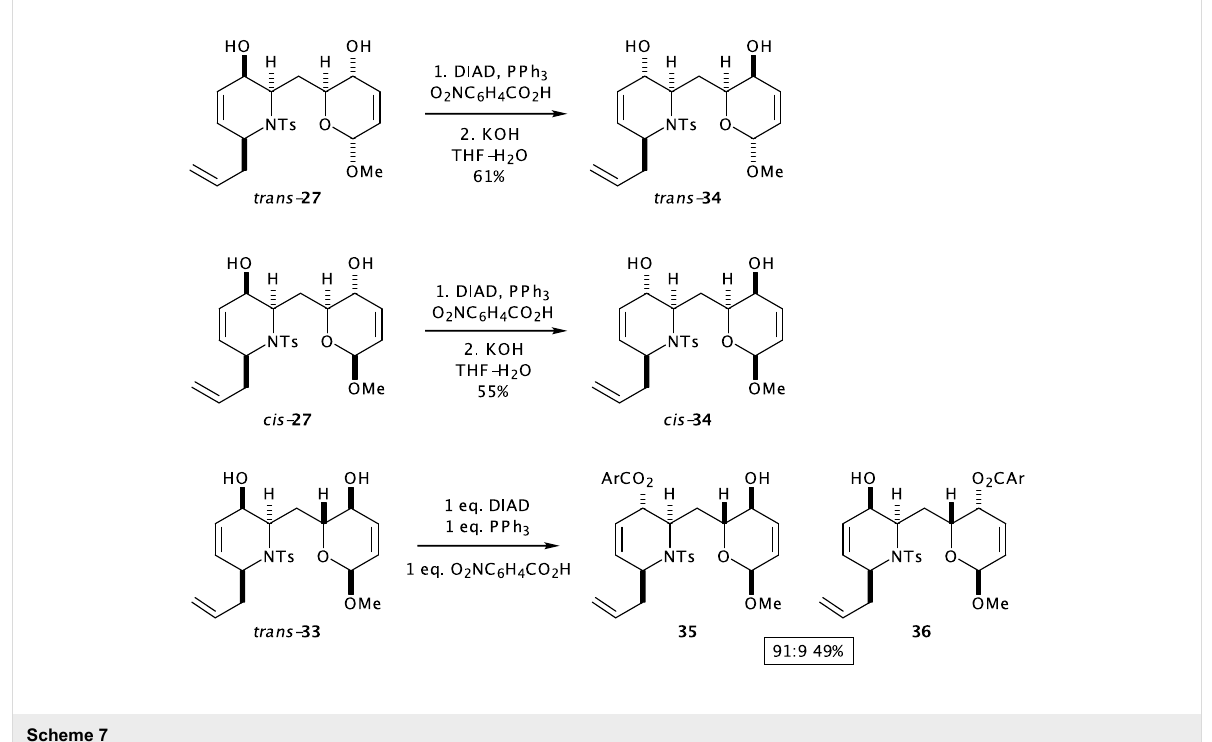
The outcome of the dihydroxylation of the bis-allylic alcohol 31 depended on the reagent used. Although dihydroxylation anti to the hydroxyl group in the dihydropyran ring was always observed (→ d' configuration),[34-37] reaction occurred either anti to (under Upjohn conditions) or syn to (under Donohoe's conditions) the hydroxyl group in the piperidine ring (→ A or B conuration respectively) (see Figure 7). In the synthesis of 37 , the stereochemical outcome is different in each of the rings ( syn to one hydroxyl group, and anti to the other). With a substituent in the 6-position of the piperidine ring, the complementarity between the alternative methods was lost. With the substrates 29 , trans - 27 and trans - 33 ,